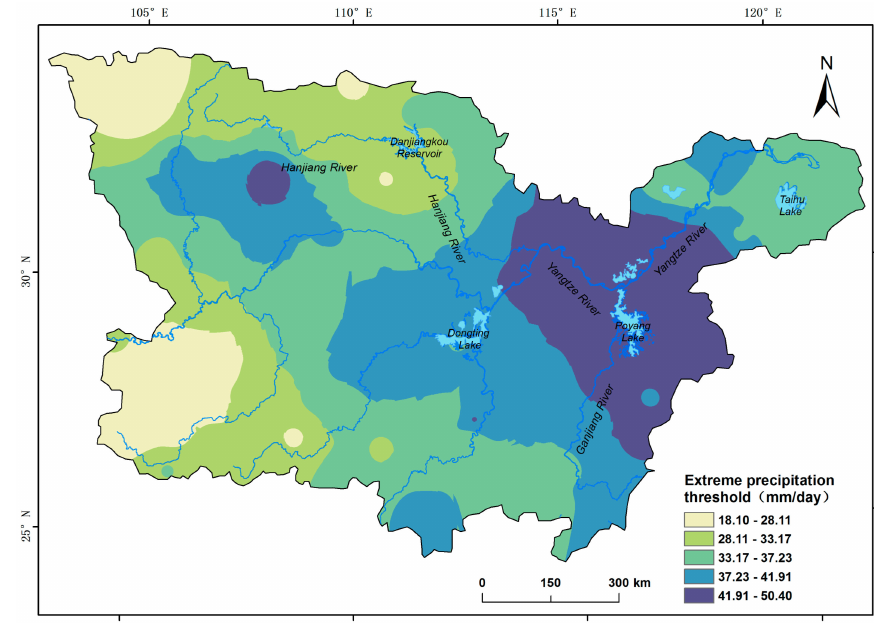
Figure 3. Precipitation amount at the 95th percentile over the period of 1961–2012 in the